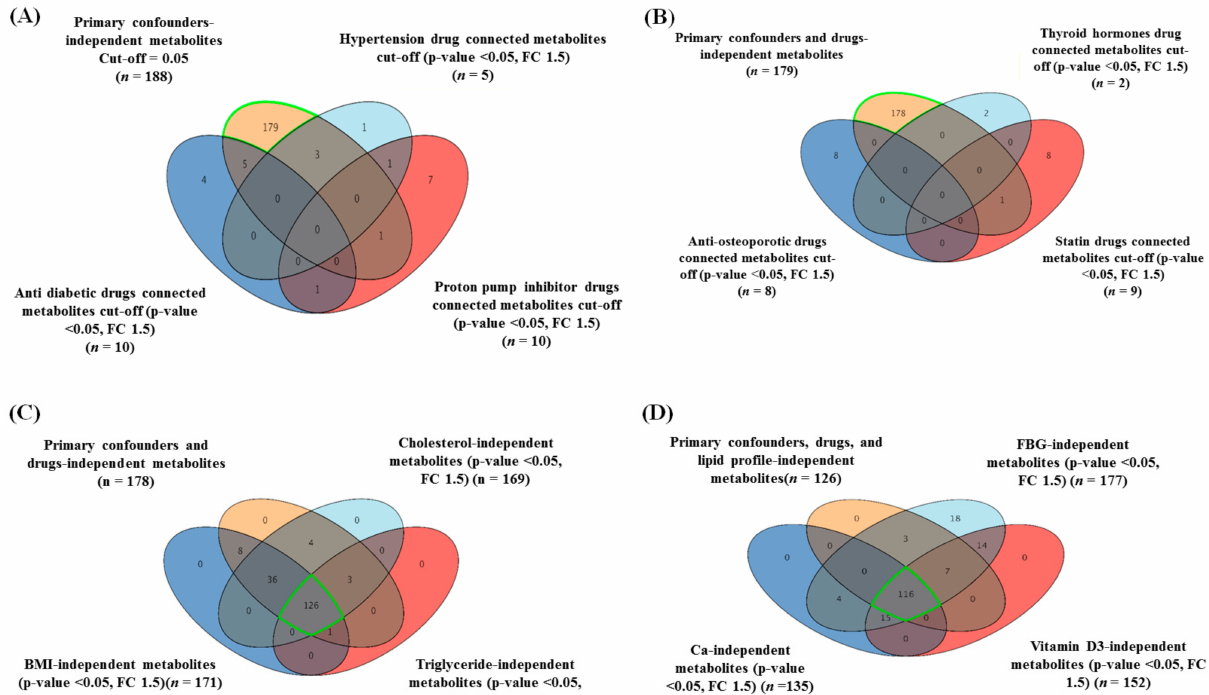
Figure 2. A sequential exclusion of drug- ( A , B ) and secondary confounder-related metabolites ( C , D ) from the panel of primary confounder-independent metabolites. ( A , B ) Venn diagrams illustrating the overlap between the drug-related metabolites and primary confounder-independent metabolites ( n = 188), using a moderated t -test considering fold-change (FC) = 1.5 and cutoff p -value < 0.05. A total of 178 metabolites were identified as both drug- and primary confounder- independent metabolites after the exclusion of 10 metabolites. ( C ) Venn diagram illustrating the overlap between metabolites independent of secondary confounders (cholesterol, BMI, and triglycerides (TG)) ( n = 169, 171, and 130, respectively) and the primary confounder- and drug-independent metabolites identified in ( B ) ( n = 178), using a moderated t -test considering fold-change (FC) = 1.5 and cutoff p -value < 0.05. A total of 126 metabolites were identified as metabolites independent from the effects of the primary confounders, drugs, lipid profile, and weight. ( D ) Venn diagram demonstrating further overlap between secondary confounder (FBG, vitamin-D3, and calcium)-independent metabolites ( n = 177, 152, and 135, respectively) with the primary confounder, drug, lipid profile, and independent weight metabolites identified in ( C ) ( n = 126), using a moderated t -test considering fold-change (FC) = 1.5 and cutoff p -value < 0.05. A total of 116 metabolites were identified as significantly associated with LBMD independent of the effect of primary and secondary confounders and